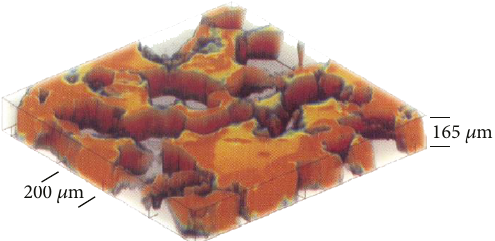
Figure 1: Reconstruction of 3D digital cores using confocal laser scanning method (the pore space is opaque (colored) and the solid matrix is translucent). It is obvious that the thickness of 3D digital cores obtained by LSCM method is low. This leads to too little information on the obtained 3D digital core, and the results of numerical simulation using 3D digital cores are not representative. Figure from